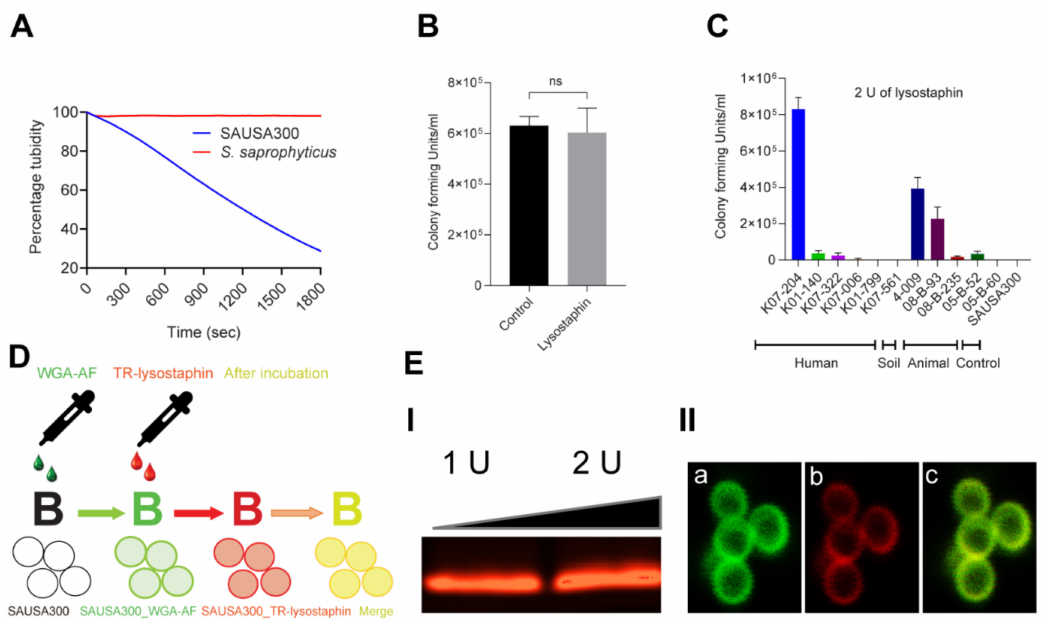
Figure 1. Lysostaphin resistance pattern in ST72 isolates and the e ffi ciency of lysostaphin binding to the cell wall of Staphylococcus aureus. ( A ) Lysostaphin mediated killing kinetics of lysostaphin susceptible S. aureus USA300 ( lys s ) in comparison to the lysostaphin-resistant Staphylococcus saprophyticus ( lys r